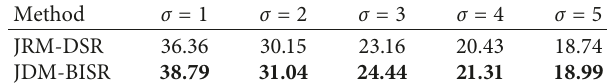
Table 9: Image matching results comparison in terms of scale variation, where the size of the blurry input image is 40 × 40.